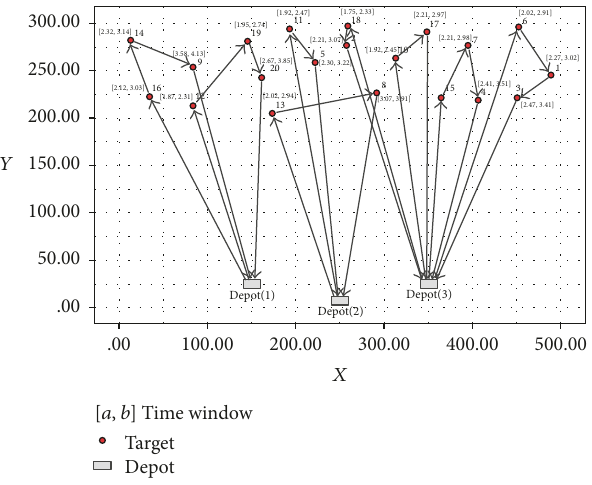
Figure 3: An illustration of the routing results for instance